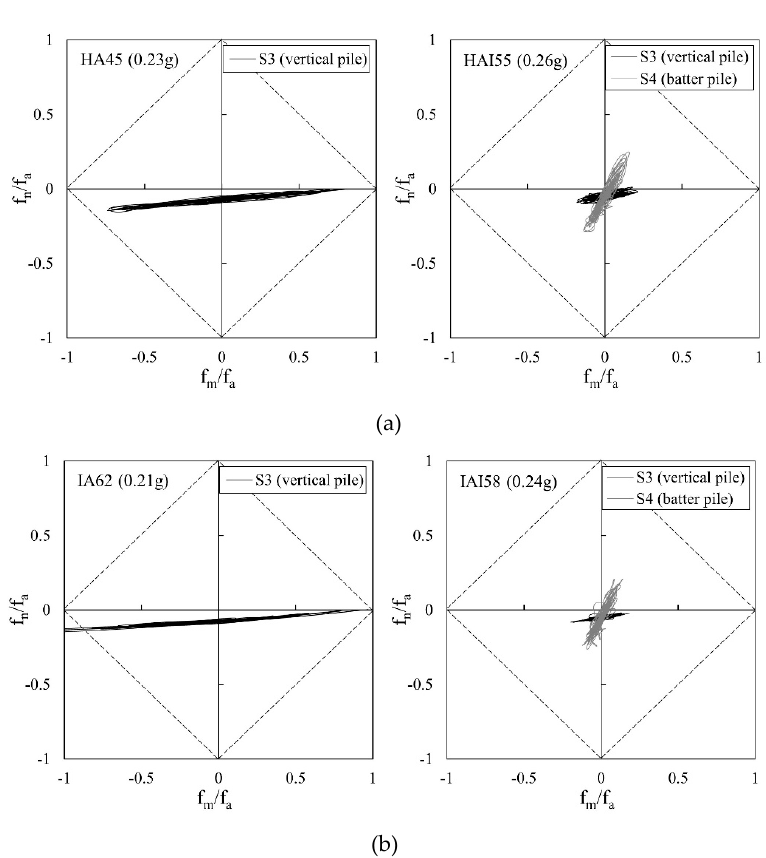
Figure 16. Relationship between bending moment and axial force (input peak acceleration exceeds 0.2 g, scaled to the prototype): ( a ) horizontal ground model and ( b ) inclined ground model.